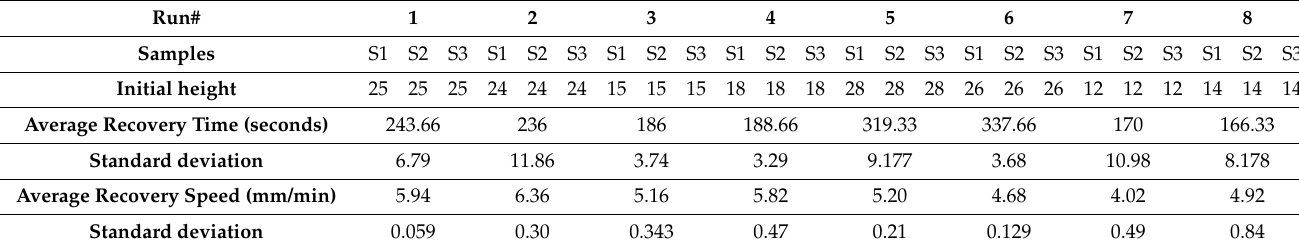
Table 2. Average calculated values for recovery speed and time for each experiment.